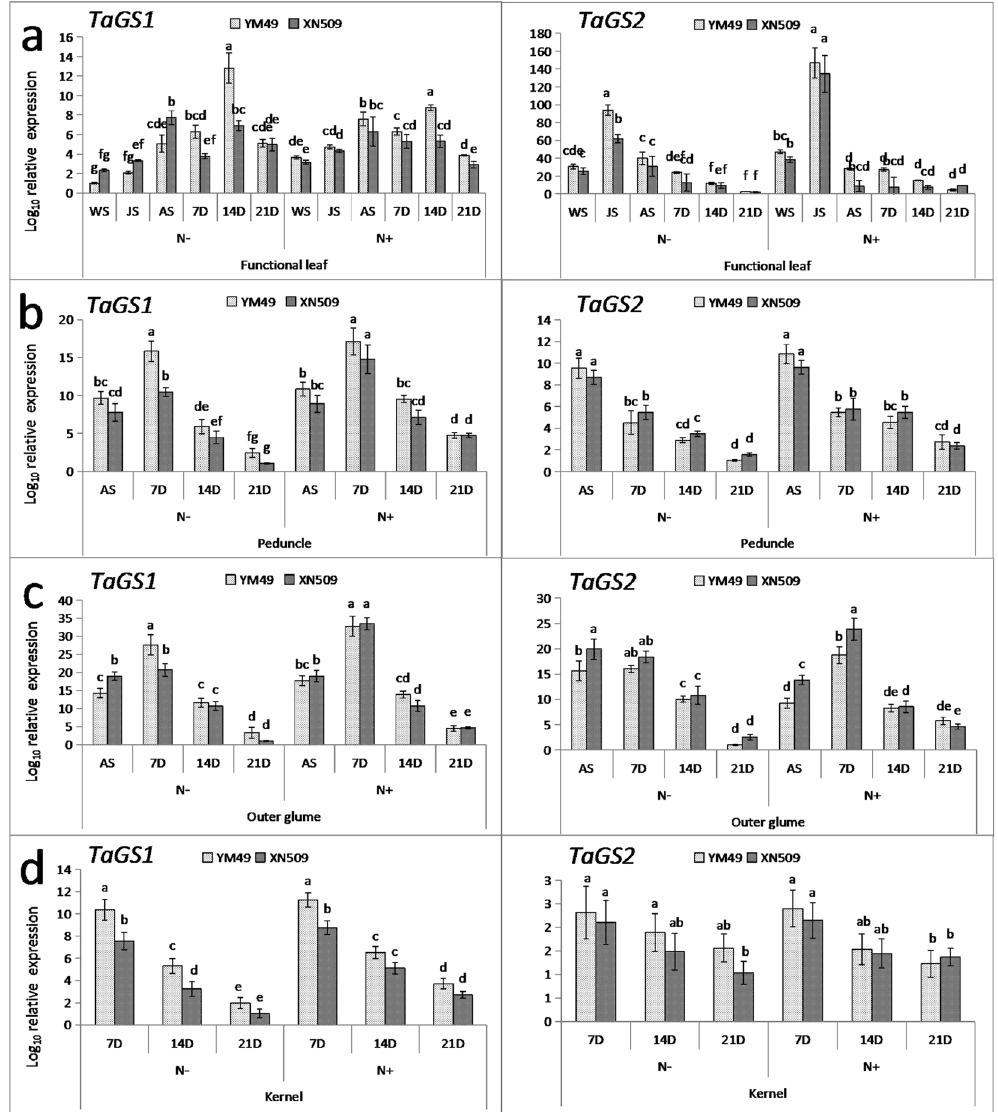
Figure 4. Transcription levels of the TaGS1 and TaGS2 genes in various plant organs grown under low (N − ) and high (N + ) nitrogen conditions. Log 10 relative expression values are shown. Data are means ± SE (standard error), three biological replicates. Letters indicate statistical differences ( p < 0.05). TaGAPDH was used as the reference